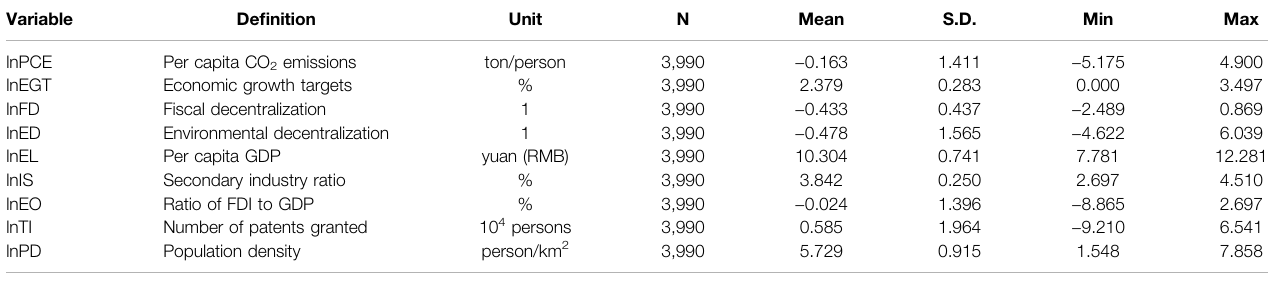
TABLE 1 | Statistical description.